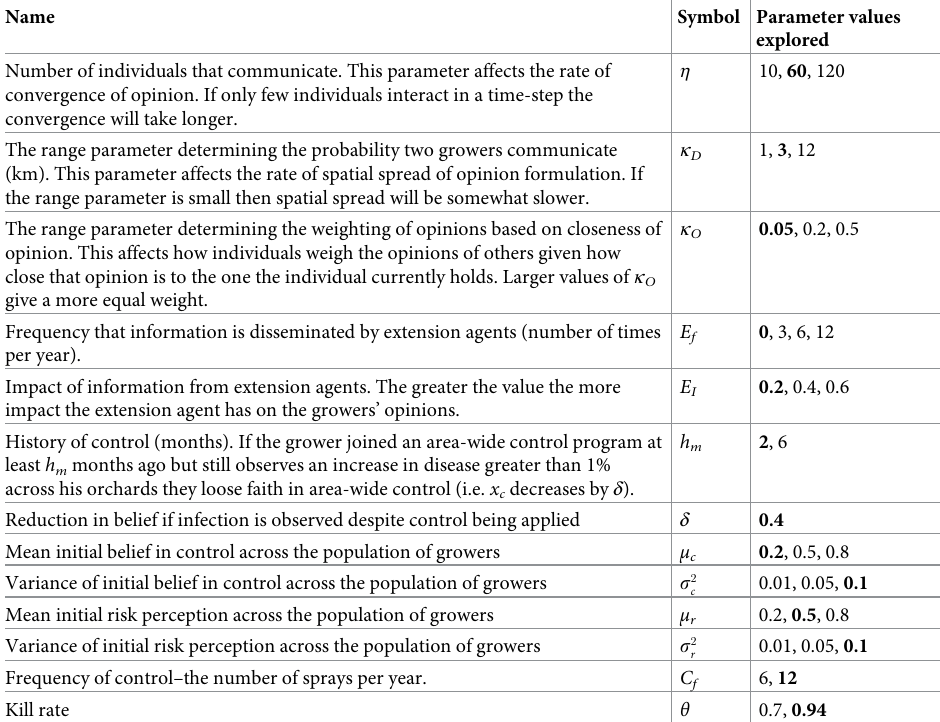
explored η 10, 60 , 120